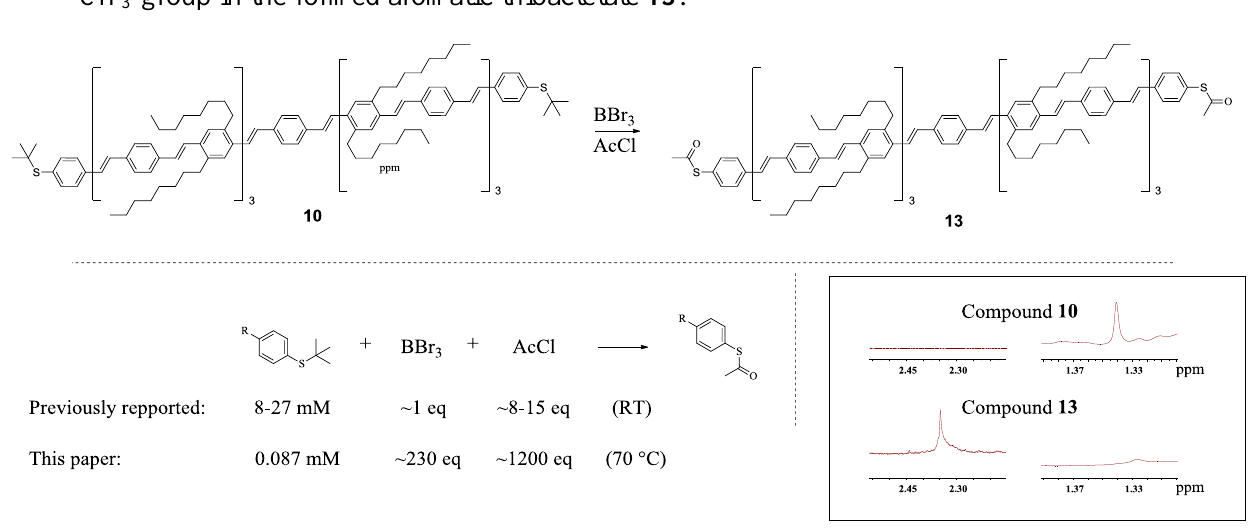
Scheme 3. top : Thioacetate functionalization of oligomer with 15 phenyls. Bottom left : Schematic representation of the reaction conditions previously reported for the conversion of aromatic tert -butyl thioether into the corresponding aromatic thioacetates (Ref. [26]) compared to the reaction conditions required for the transformation of oligomer 10 . This demonstrates that reaction conditions on very large molecules cannot always be directly transferred from standard reactions. Bottom right : 1 H-NMR of compound 10 and 13 in C D Cl showing disappearance of the singlet signal (~1.33 ppm) from the tert -butyl 6 4 2 thioether of compound 10 and formation of the singlet signal (2.35 ppm) from the CH -group in the formed aromatic thioactetate 13 3